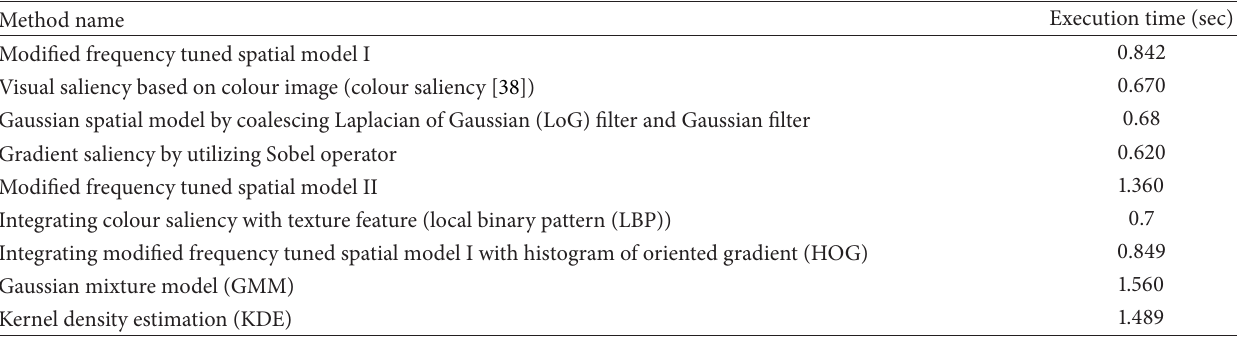
Table 2: Comparison of time analysis of proposed